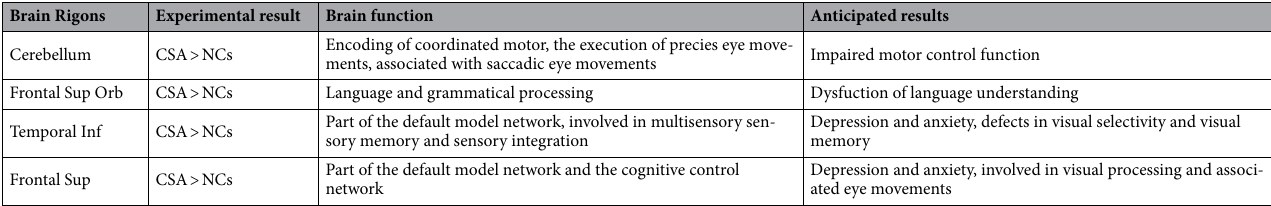
Table 4. Brain regions alteration and its potential impact. CSA children with strabismus and amblyopia, NCs normal